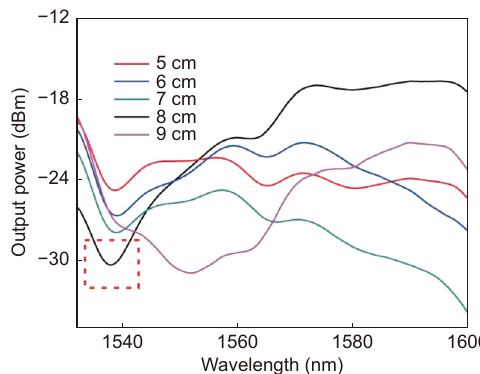
Fig. 7 | Transmission spectra of the RI sensor with different POF length.